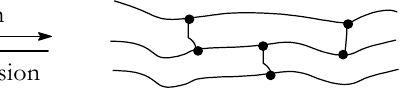
Figure 3. Indirect polymerization of HV polymer. Low voltage quinone-based polymers like P.A.Q. can be directly polymerized with Ni(C.O.D.) 2 . Whereas indirect multistep polymerization prevents the oxidation of Ni(C.O.D.) 2 while protecting quinone groups with acetyl groups helped to synthesize increased operating voltage polymers such as P.F.Q. Additionally, P.F.Q./rGO composite has a better porosity, enhancing electrical performance and rate capabilities compare with P.A.Q. polymers. Indirect polymerization of high redox potential ortho quinones also helps to synthesize higher operating voltage polymers such as P.F.Q. preferred over direct polymerization of para-quinones producing low voltage polymers. 2.2.2. Thermoplastic High Performance for Cable Insulation System The polyethylene is cross-linked with different fillers’ sizes to change the polymer’s physical properties and make it capable of working with HV systems (cable system).